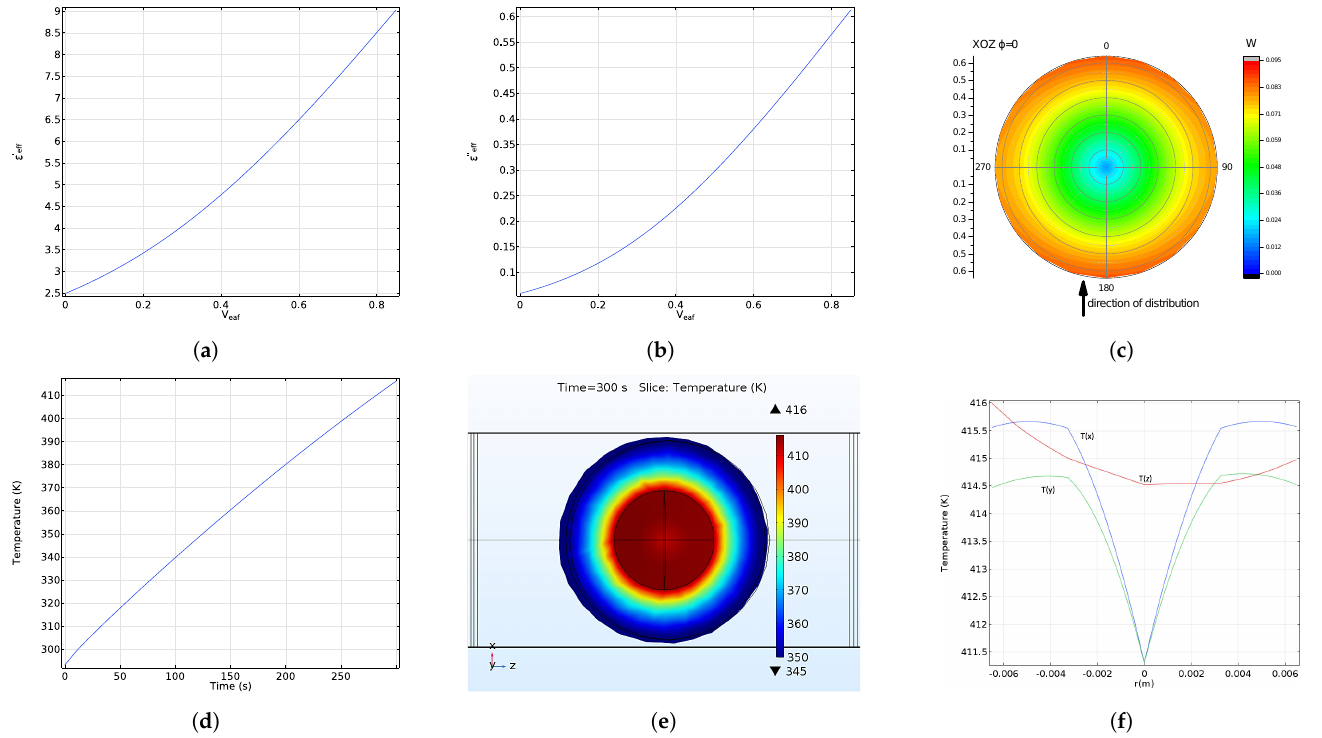
Figure 10. Dependencies of dielectric permittivity (real and imaginary parts) on the volume fraction of EAF dust for a biochar conductivity of σ eaf = 10 8 s − 1 ( a , b ). Distribution of heat sources (analytical solution for plane wave in free space) ( c ), temperature curve ( d ), and temperature distribution within pellet ( e , f